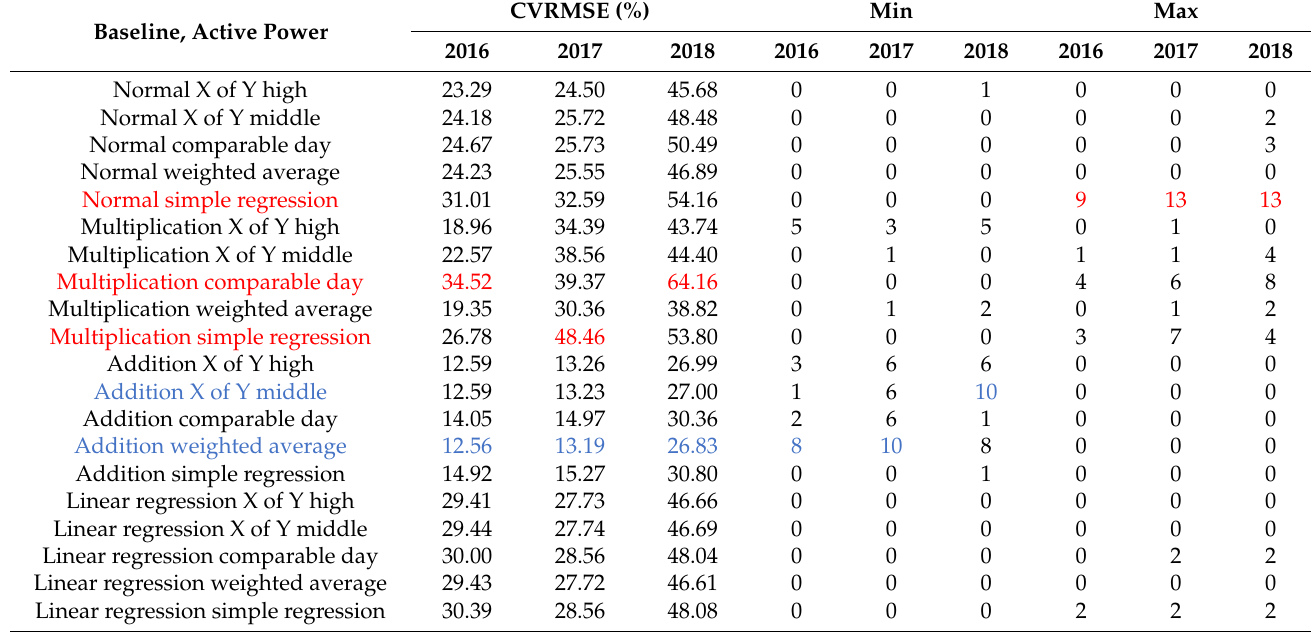
Table 4. Baseline, active power, CVRMSE (highlighted in red are the worst results, highlighted in blue are the best results). Baseline, Active Power